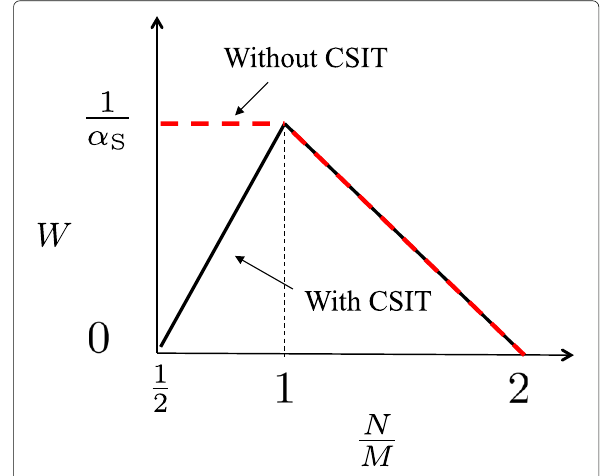
Fig. 7 Spatial spectral tradeoff in Case A when α I =